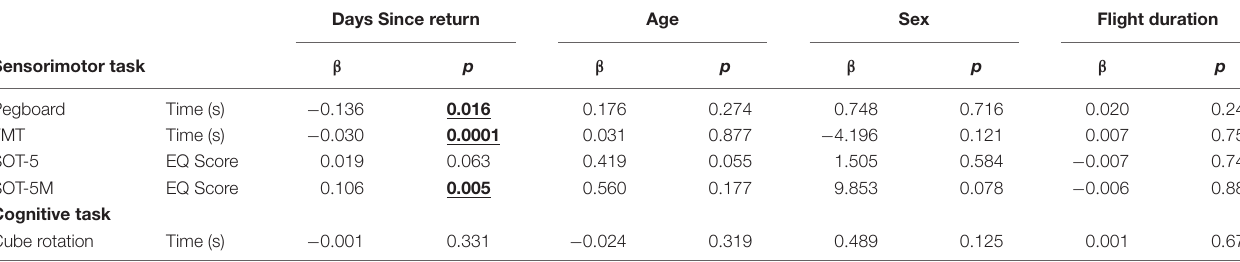
TABLE 4 | Recovery from the microgravity environment. Days Since return Age Sex Flight duration